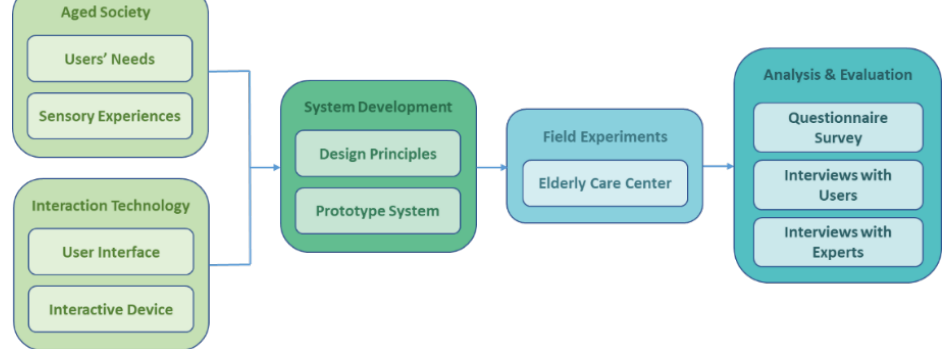
Figure 2. Illustration of the research process of this study.